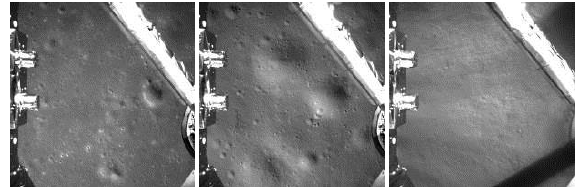
Figure 8. Descent images acquired approximately at 4.2 km, 100 m above the lunar surface and after touch